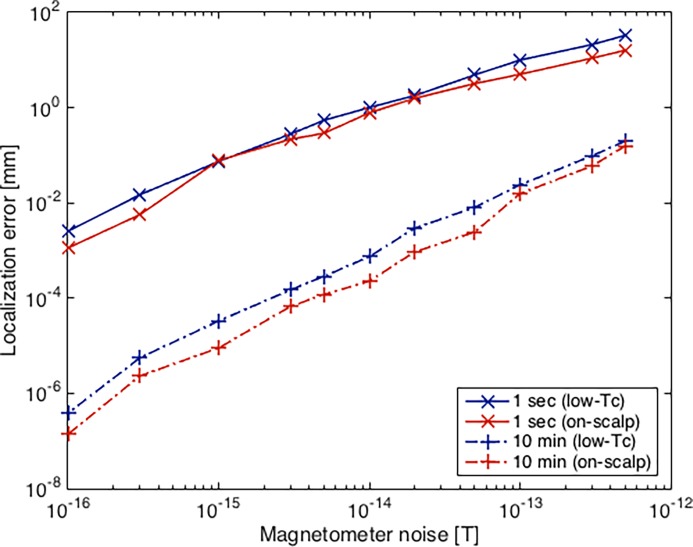
Localization error vs. SNR for different measurement time.Mean localization error with low-Tc (solid) and on-scalp (dashed) systems for different data lengths. Magnetic moment = 1 nAm2. Both axes are plotted logarithmic.